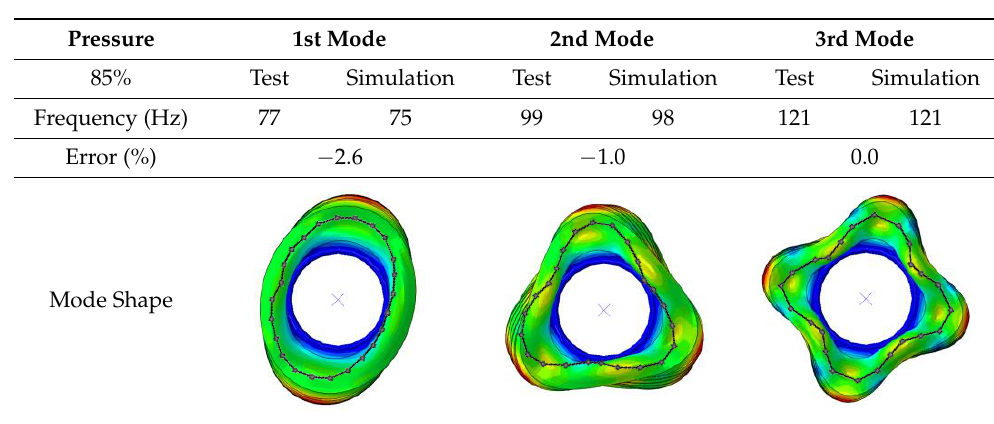
Table 7. Comparison of the modal frequencies and modal shape between the experiment and sim- ulation (Pressure 100%).